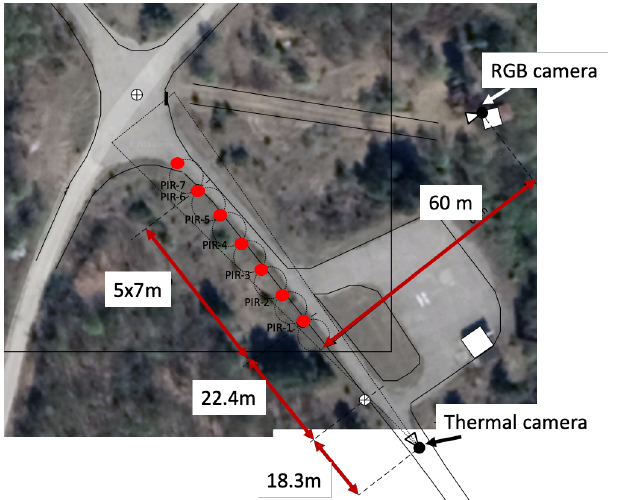
Figure 2. Sensor deployment in the experimental setup. RGB and thermal cameras are signed with arrows. PIR sensors indicated with red